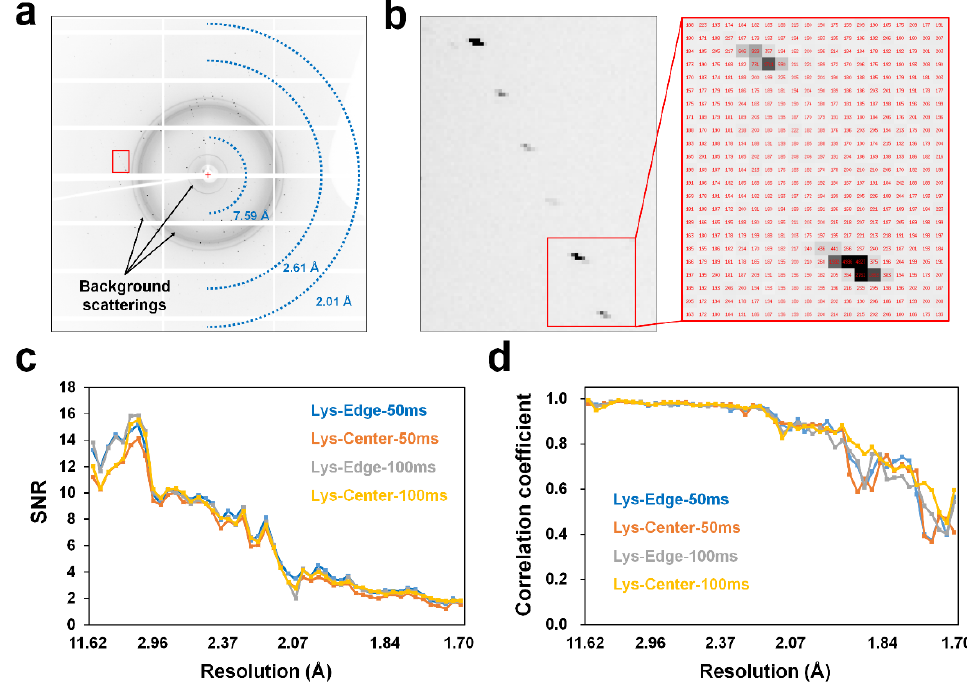
Figure 2. Analysis of pink-beam SSX data. ( a ) Typical diffraction images. ( b ) Close-up view of Bragg peaks. Comparison of the ( c ) SNR and ( d ) CC from four different pink-beam SSX data.